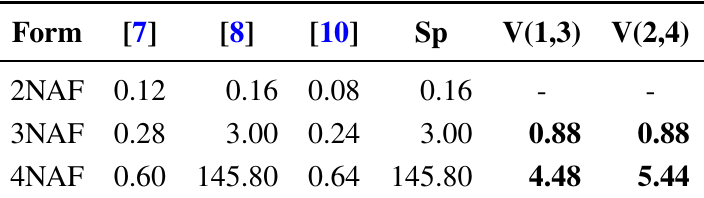
Table 6. Size (Kbyte) of the look-up table in the case of a 160-bit scalar (Lim and Lee’s method uses a normal representation) . Sp: speed optimized version; V(1,3): size optimized version 1 and 3; V(2,4): size optimized version 2 and 4.